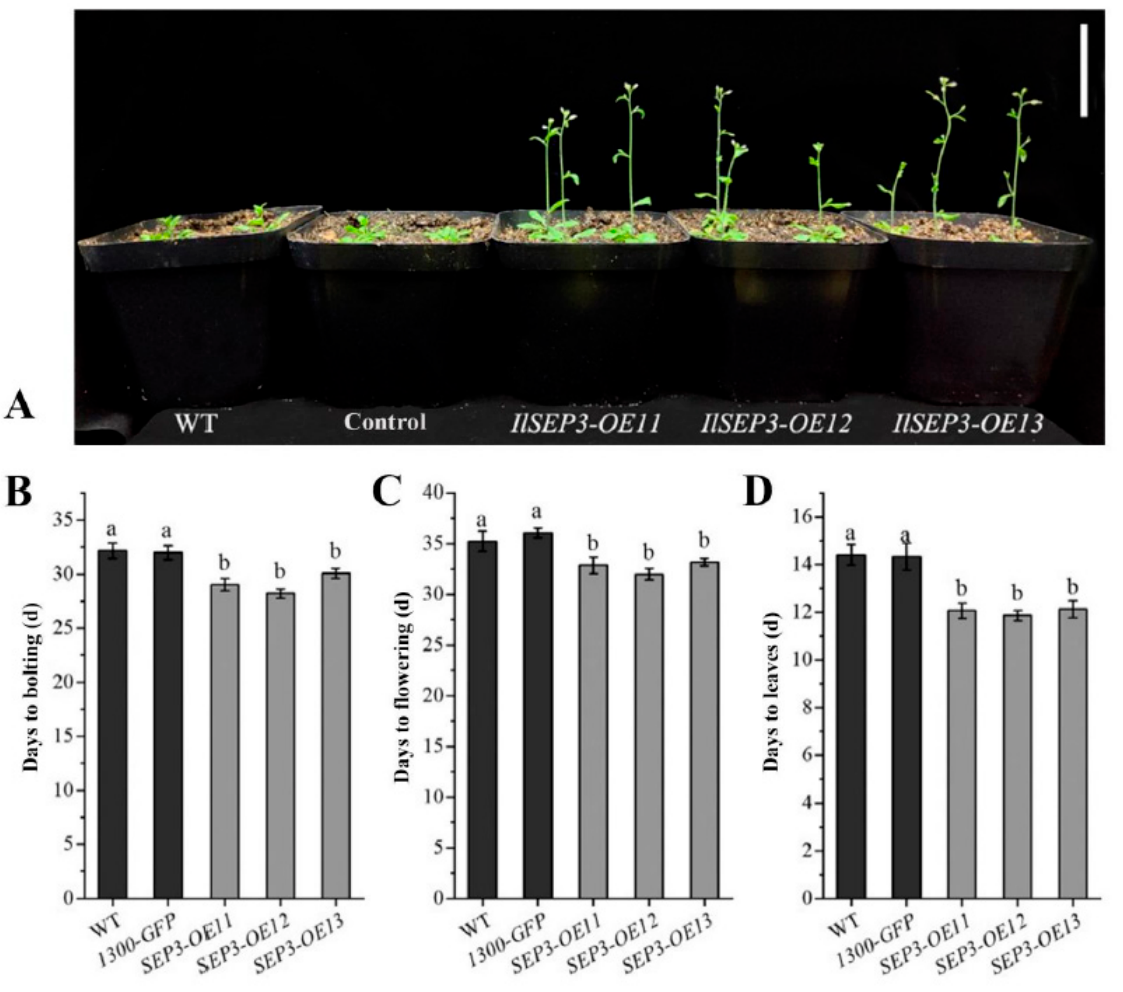
Figure 6. Phenotypes of transgenic Arabidopsis overexpressing IlSEP3 . ( A ) Representative plants grown under long-day conditions. Bar = 10 cm. ( B ) Days to bolting (inflorescence stalk of 1 cm). ( C ) Days to flowering (opening of the first flower). ( D ) The number of rosette leaves at the time of flowering. All data represent mean ± standard error. Statistical difference was denoted by lowercase letters ( p < 0.05).